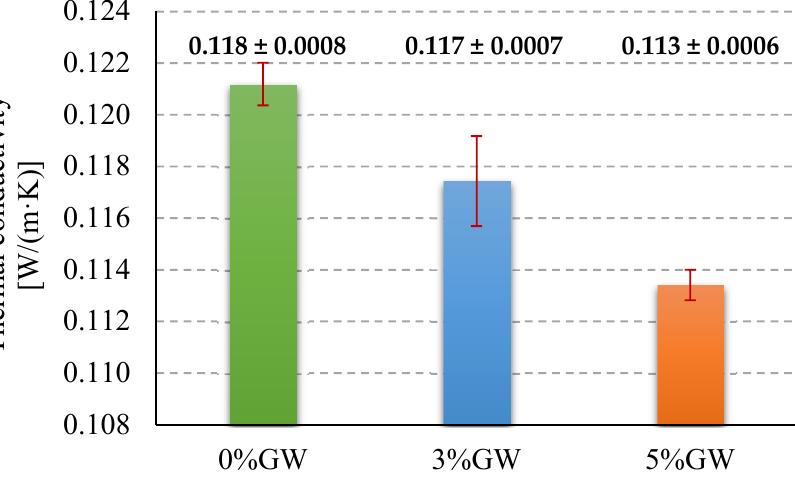
Figure 9. Thermal conductivity coefficient of tested